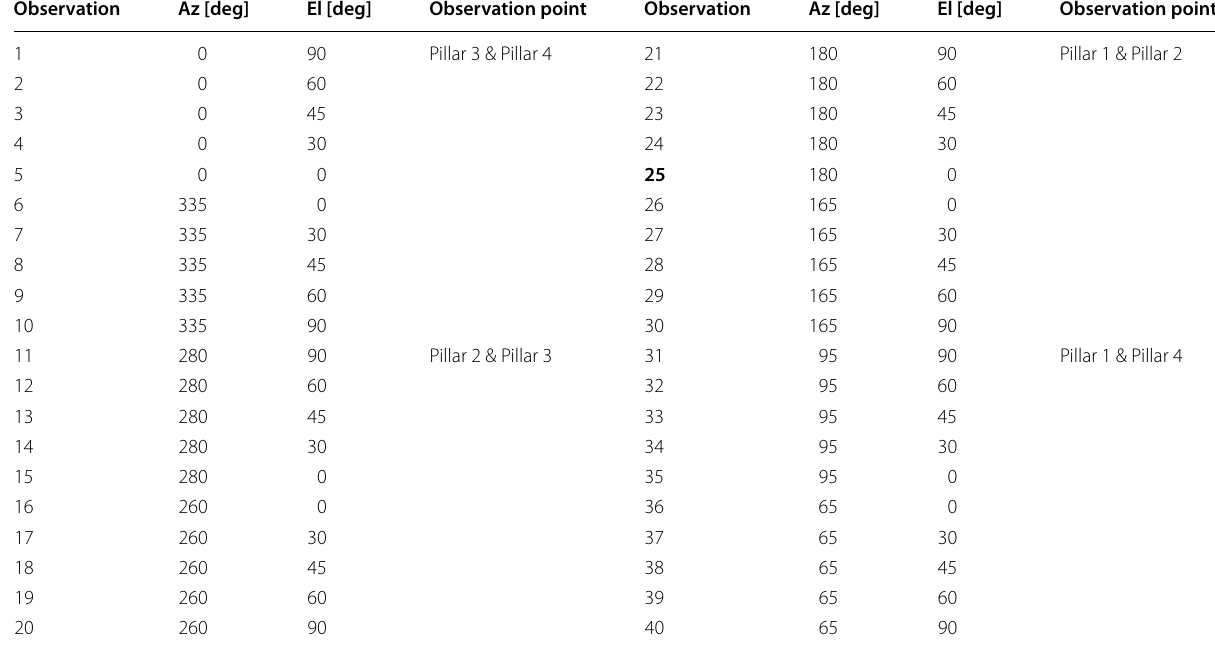
Table 1 Combination of antenna’s rotation angles and observation pillars for the outside method. The Az angle is measured from north clockwise, and the El angle is measured from horizon to zenith. Observation 25 is not used for the calculation due to outlier Observation